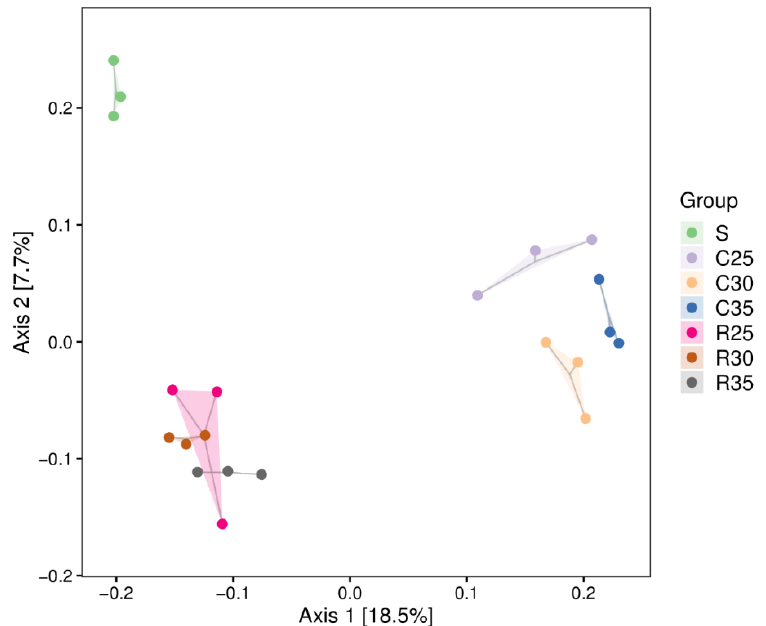
Figure 2. The unweighted Principal coordinate analysis (PCoA) of bacterial communities for corn stover or rice straw silage mixed with soybean curd residue (S, soybean curd residue; C35/R35, soy- bean curd residue: corn stover/rice straw at 65:35; C30/R30, soybean curd residue: corn stover/rice straw at 70:30; C25/R25, soybean curd residue: corn stover/rice straw at 75:25). The bacterial communities of each group were identified and 20 dominant bacteria were screened. The relative abundances of dominant bacteria in the silage samples at the genus level are shown in Figure 3. In the SCR and CS mixed silage treatment groups, Rah- nella (41.5%) was the dominant genus in the C35 group, followed by Lactobacillus (39.6%), Pantoea (3.2%), Serratia (2.7%), and Leuconostoc (1.7%). The relative abundance of the domi- nant bacteria in silage samples gradually changed with the increase in the proportion of SCR in raw materials. The dominant genera in the C30 group were Lactobacillus (55.3%), Rahnella (23.8%), Brachybacterium (2.7%), Serratia (2.3%), and Leuconostoc (2.2%). The dom- inant genera in the C25 group were Lactobacillus (66.2%), Rahnella (18.4%), Leuconostoc (2.5%), Lactococcus (2.2%), and Cupriavidus (1.9%). In the SCR and RS mixed silage treatment group, Lactobacillus (65.8%), Lactococcus (17.6%), Leuconostoc (8.1%), Cupriavidus (2.8%), and Weissella (2.0%) were dominant genera in the R35 group. As the proportion of SCR in raw materials increased, the relative abundance of Lactobacillus increased to 77.8% in the R25 group, while the relative abundance of Lactococcus , Leuconostoc , Cupriavidus, and Weissella decreased to 13.4%, 3.8%, 1.7%, and 0.9%, respectively. From Figure 4, the relative abundance of Janthinobacterium of SCR was higher. In the RS treatment group, as the proportion of SCR in raw materials increased, the relative abundance of Janthinobacterium and Lactobacillus increased, while that of Weissella and Leuconostoc decreased. In the RS treatment group, the relative abundance of Serratia , Pseudomonas, and Rahnella decreased with increasing proportions of SCR.